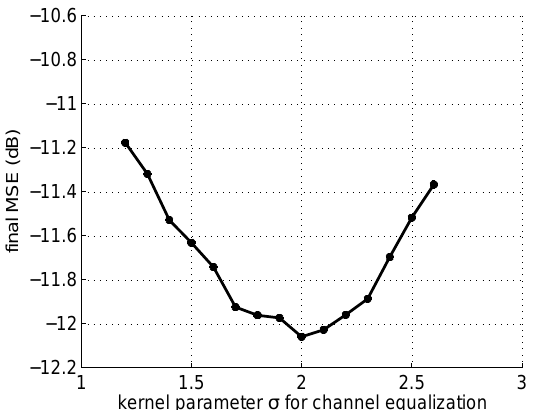
Figure 8. The final MSE curve of the KLMS-RFN algorithm with a varied kernel parameter σ from 1.2 to 2.6 in time-varying channel